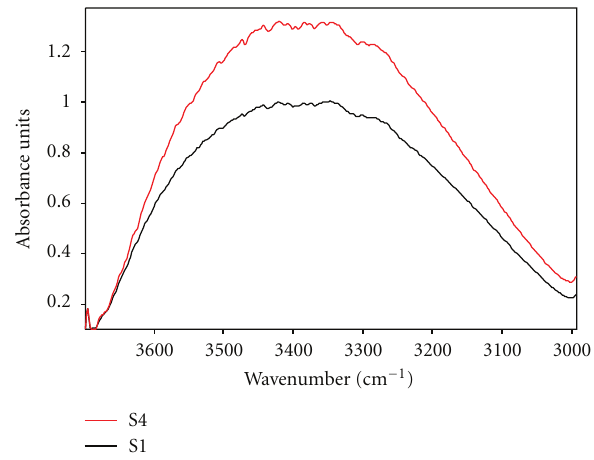
Figure 2: FT-deconvoluted OH bands (3600 to 3200 cm − 1 ); S1: biotreated; S4: untreated wood